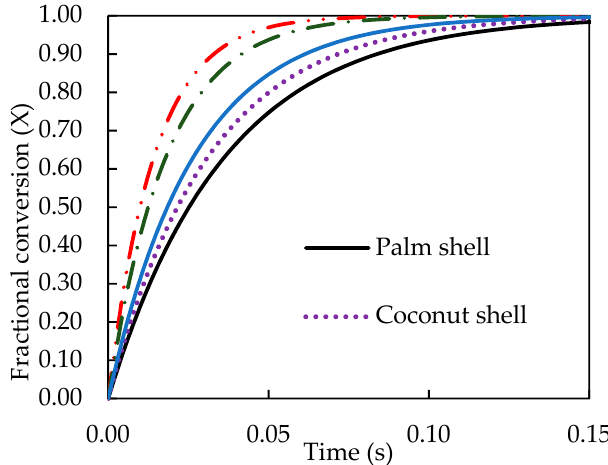
Figure 9. Effect of biomass type on the computed fractional conversion as a function of time at pyrolysis temperature of 500 °C.